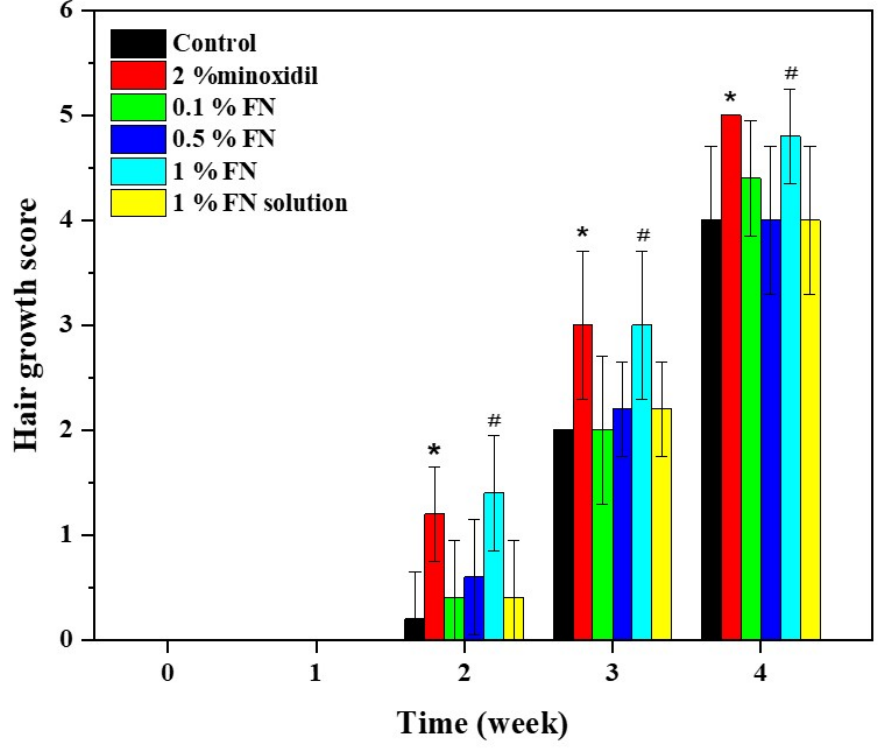
Figure 9. The hair growth scores of experimental animals. #, * p < 0.05 compared to respective control groups.